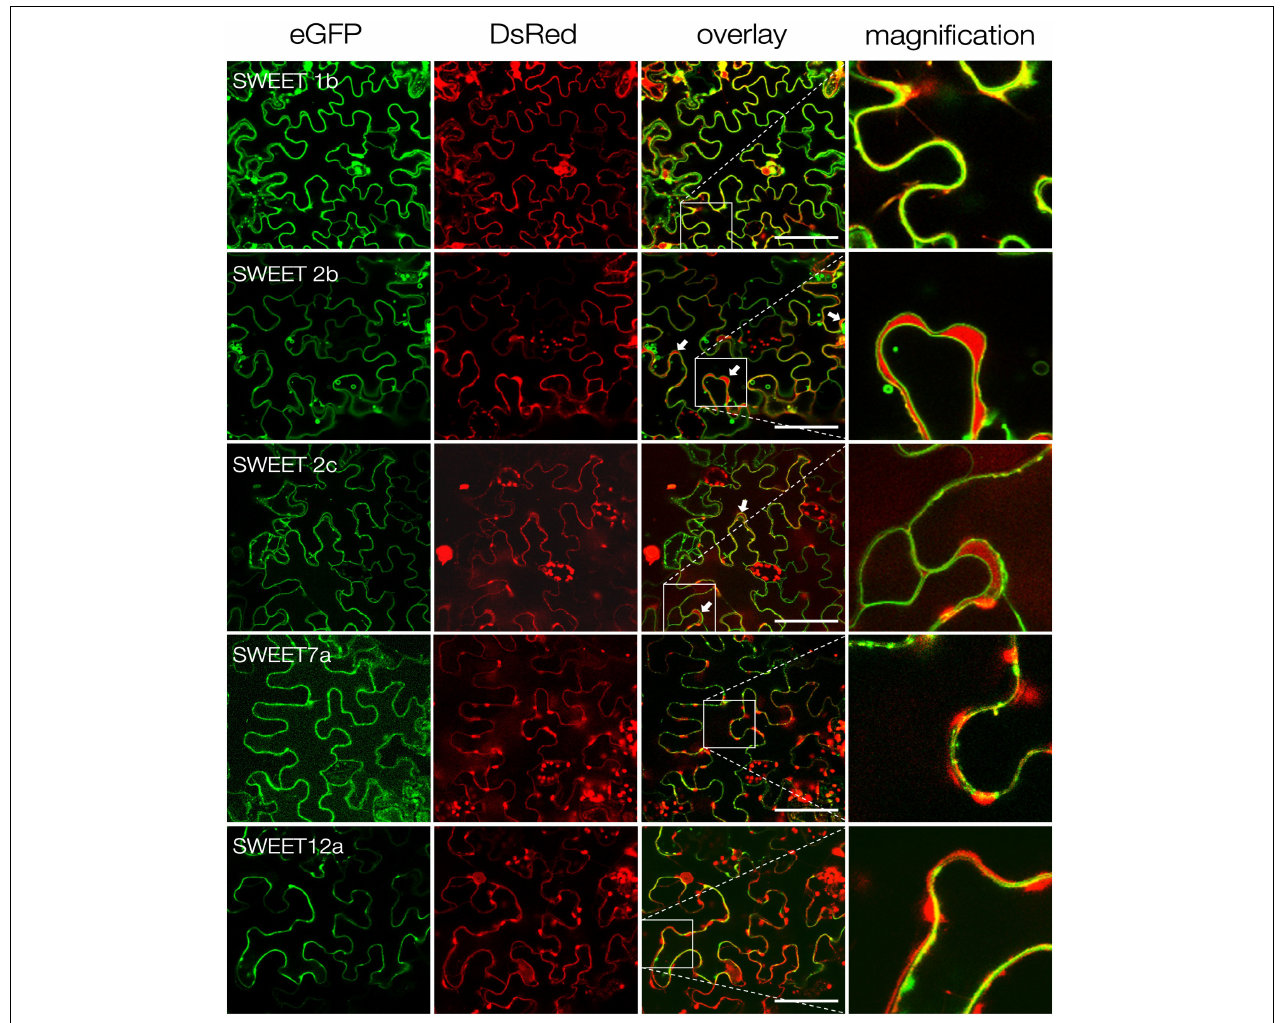
FIGURE 3 | Subcellular localization of S. tuberosum SWEET proteins. Confocal imaging of ectopically expressed potato SWEET proteins fused to eGFP in N. benthamiana epidermal cells. Free DsRed was co-expressed as control for transformation and labels the cytoplasm and the plant nucleus. White arrows indicate cytoplasmic DsRed accumulations between the tonoplast and the plasma membrane. Zoom images of inlets are shown in the last column. Scale bars are 50 µ